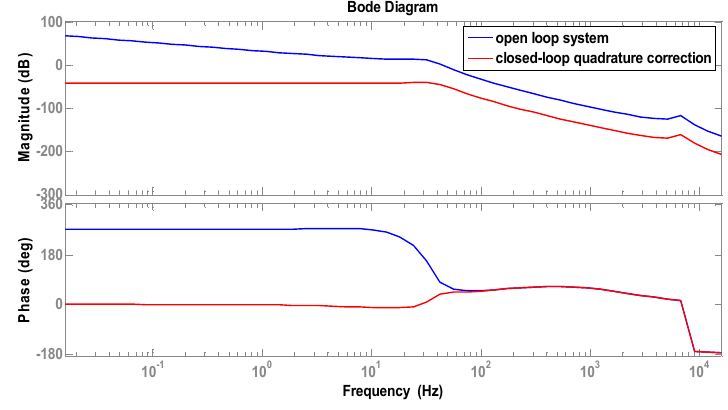
Figure 12. Bode diagram of closed-loop quadrature correction control circuits.